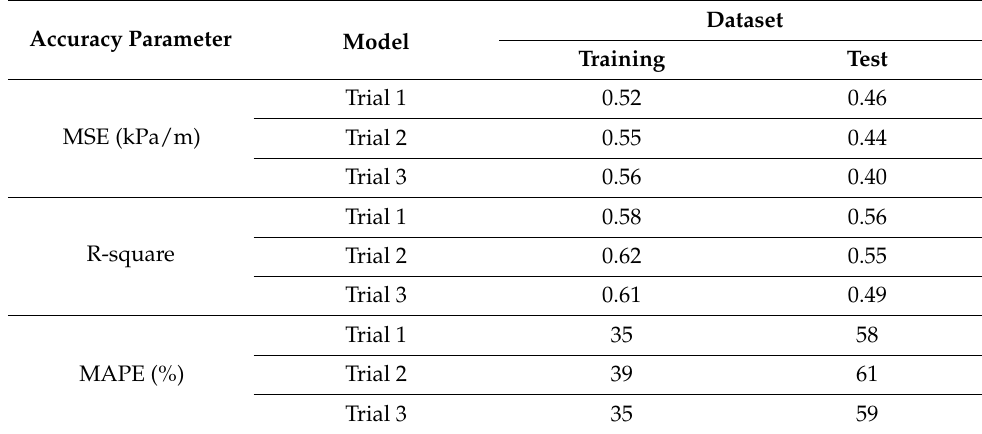
Table 6. Comparison of Accuracy Parameters for Cross-Validation of MLR.